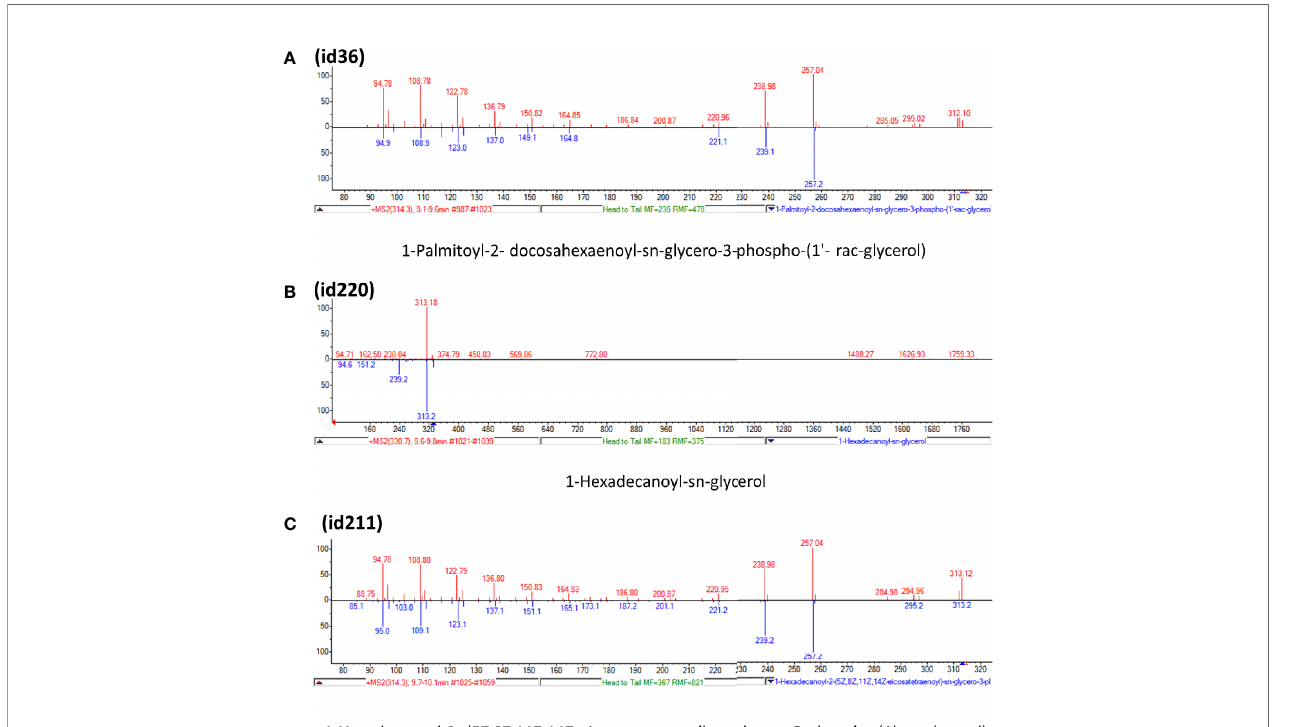
FIGURE 3 | Tandem mass spectra (MS/MS) library similarity match obtained using the NIST library. The tandem mass spectra (MS) of molecules ID36, ID220, and ID211 are